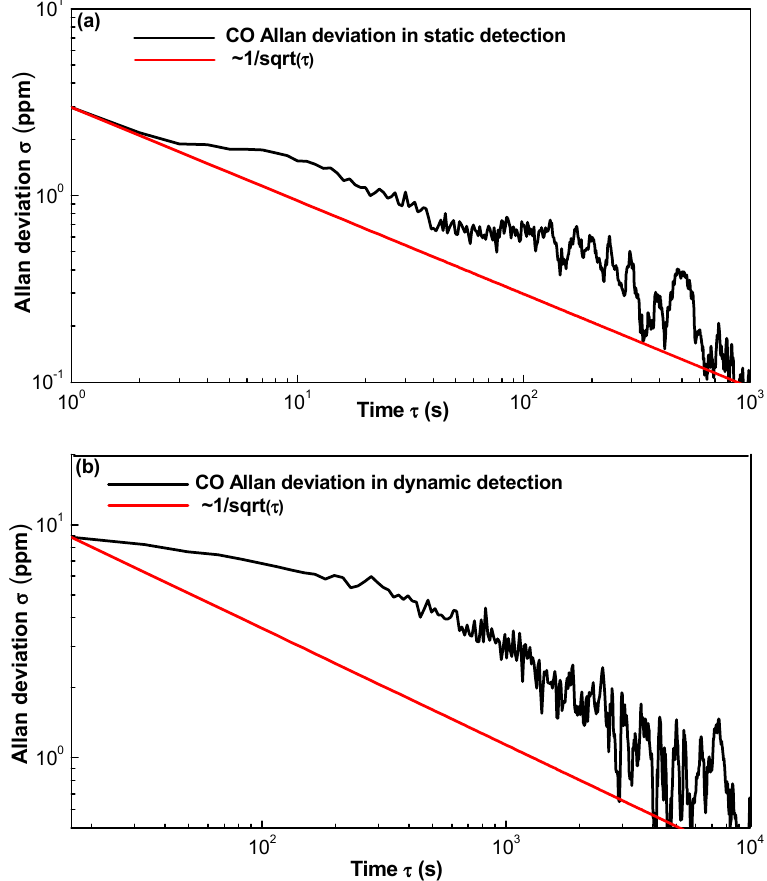
Figure 10. Allan deviation plot of the CO sensor in ( a ) static state with a sampling interval of 1 s and ( b ) dynamic state with a sampling interval of 10 s.